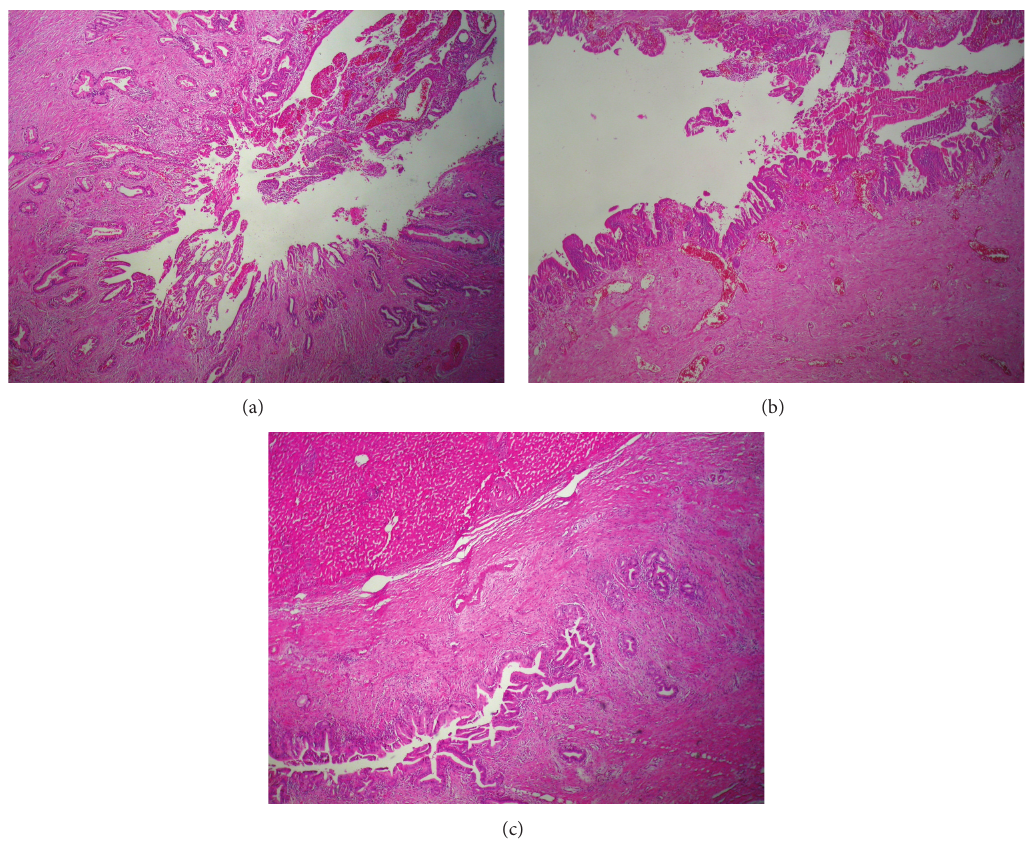
Figure 2: (a) Invasive adenocarcinoma in choledoch ( × 40 HE), (b) in situ cholangiocarcinoma in left bile duct ( × 100 HE), and (c) in situ cholangiocarcinoma in left hepatic lobe ( × 40